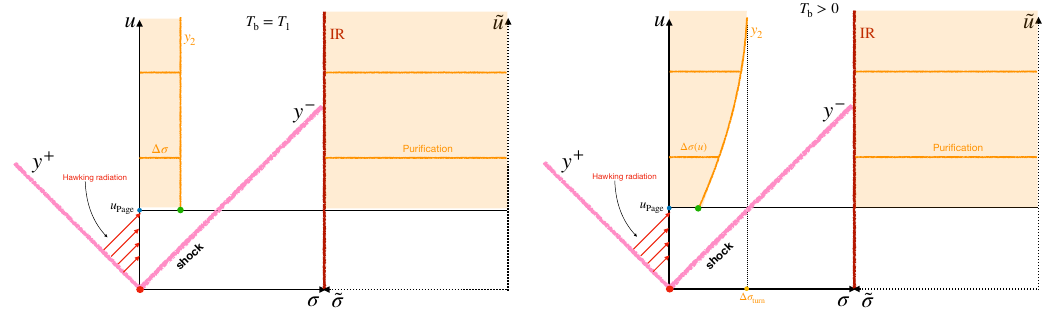
Figure 14 . The yellow shadow denotes the minimal bath region including a full half-line as the purification of thermal bath for reconstructing the interior of the black hole. The yellow lines represent the necessary bath region at a fixed time slice after Page transition. Left: the equilibrium case with T b = T 1 . Right: non-equilibrium case where k δσ ( u ) increases with the time evolution and approaches a constant ∆ σ turn defined in eq.